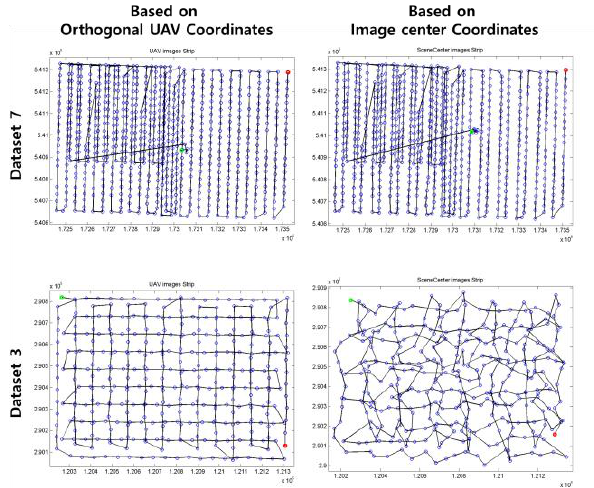
Figure 10. Path linearity of dataset 3(from eBee) and 7(from Inspire2)